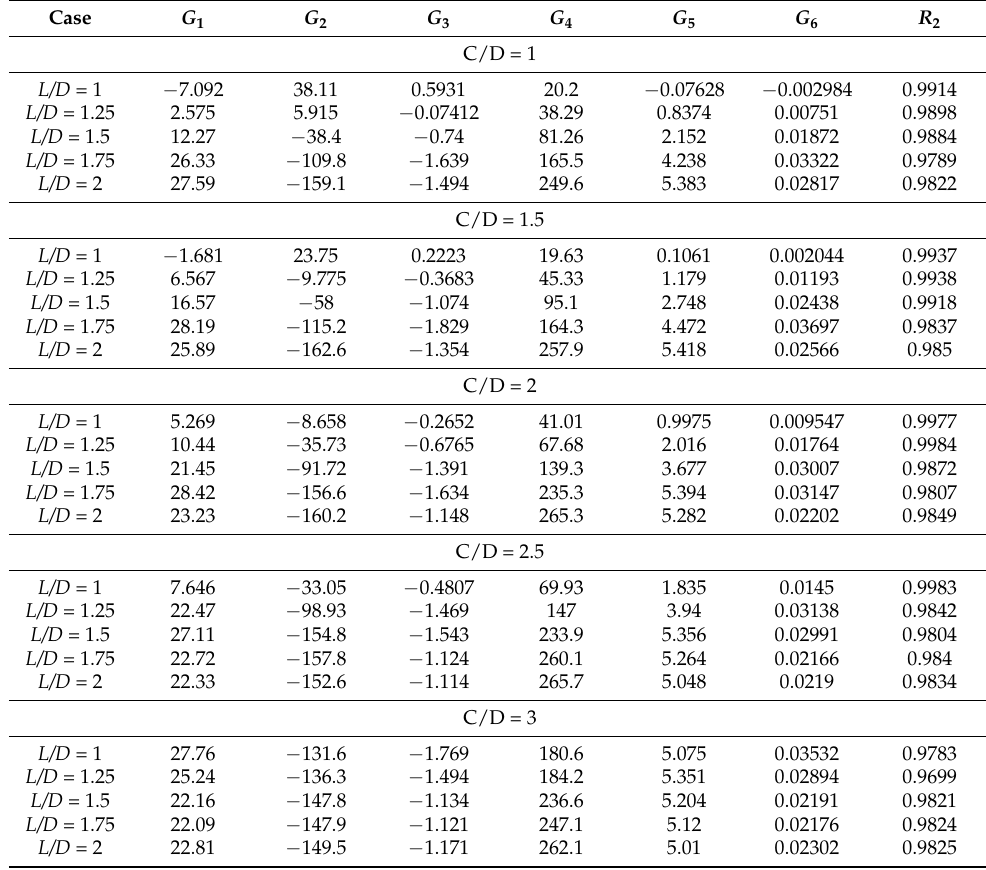
Table 8. Fitting parameters and goodness of Equation (11) in various case